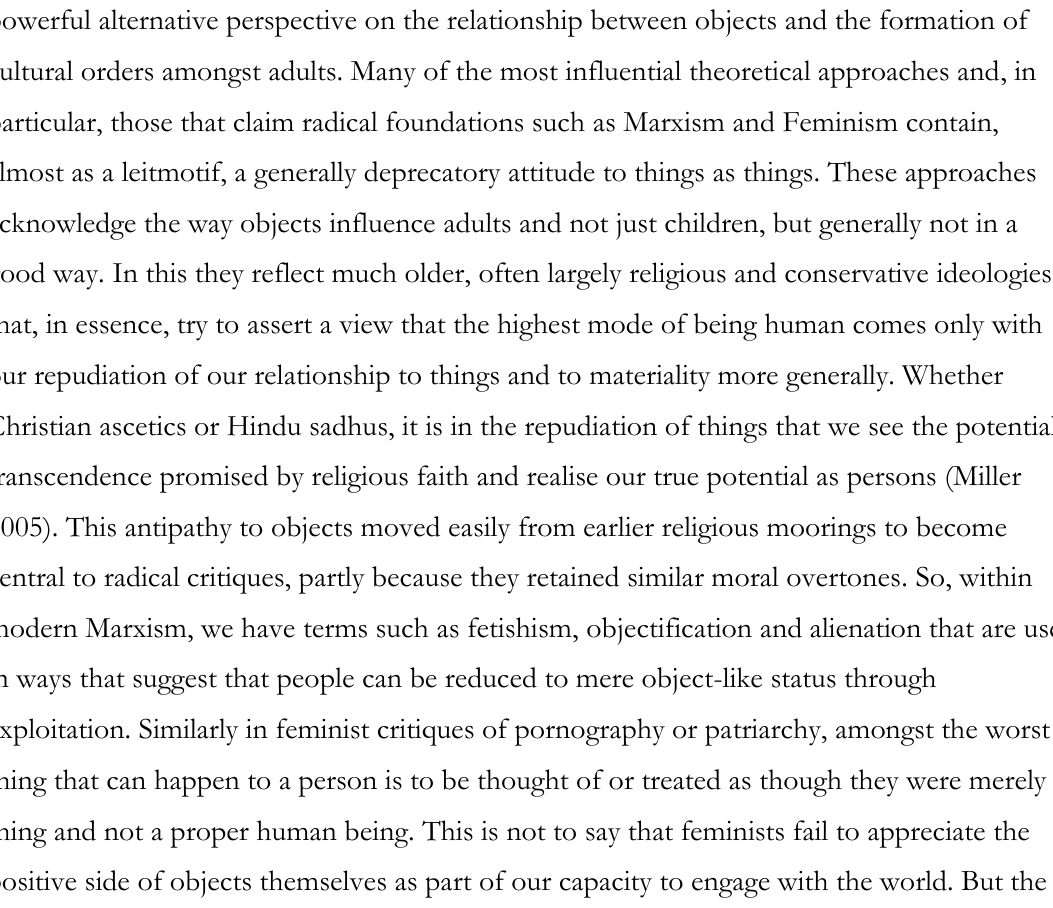
Daniel Miller: Getting THINGS Right: Motherhood and Material Culture Studies in the Maternal, 3(2), 2011,